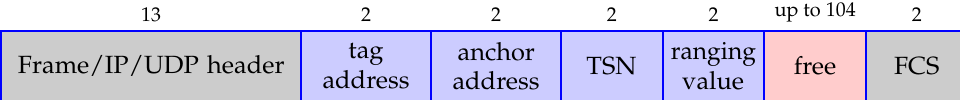
Figure 28. Structure of a ranging frame showing space left for aggregation of multiple